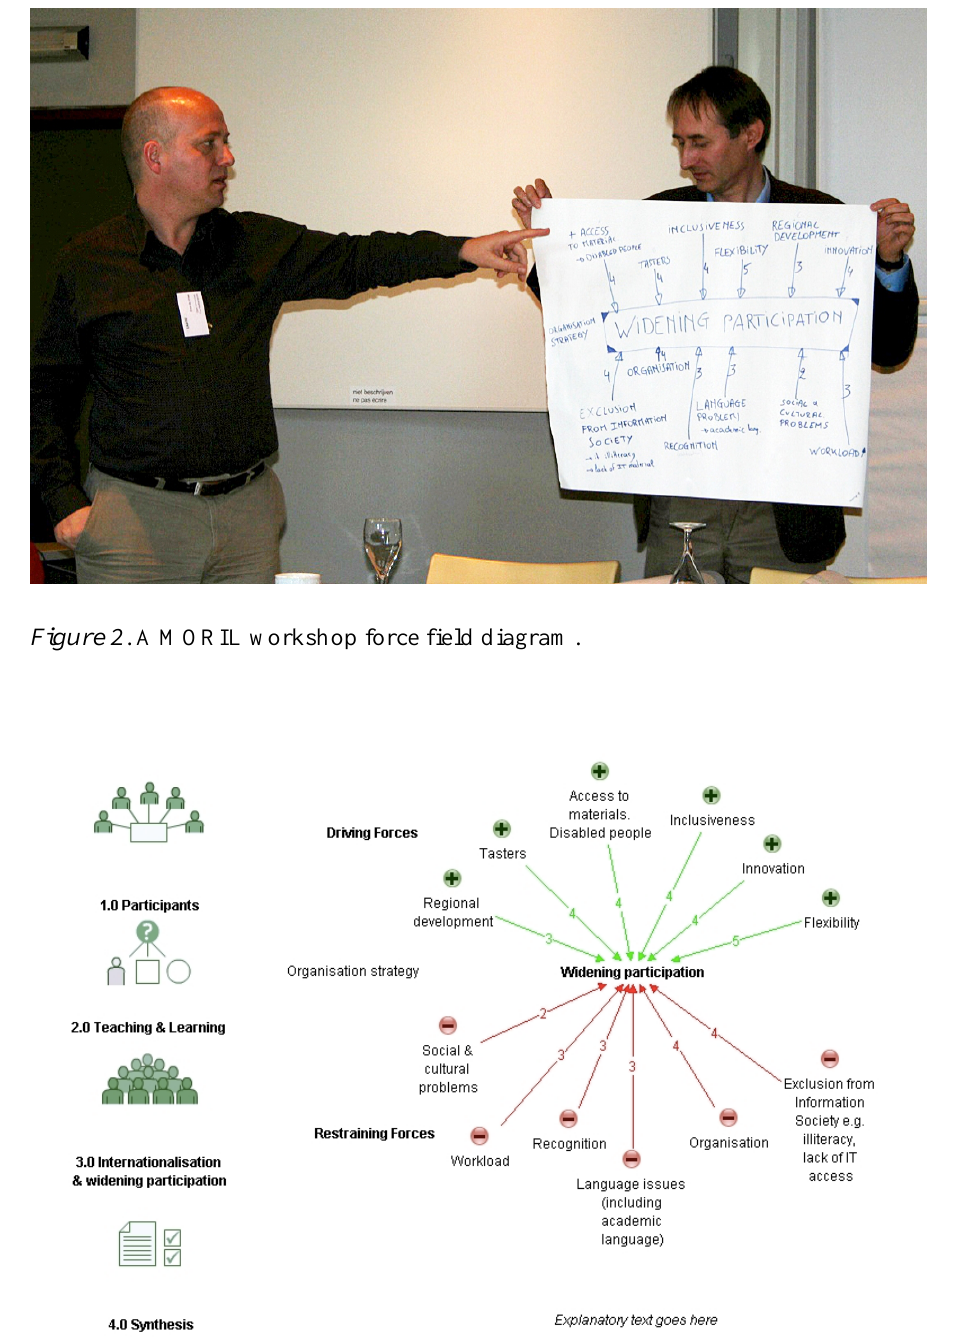
Figure 3 . A MORIL workshop Compendium map illustrating widening